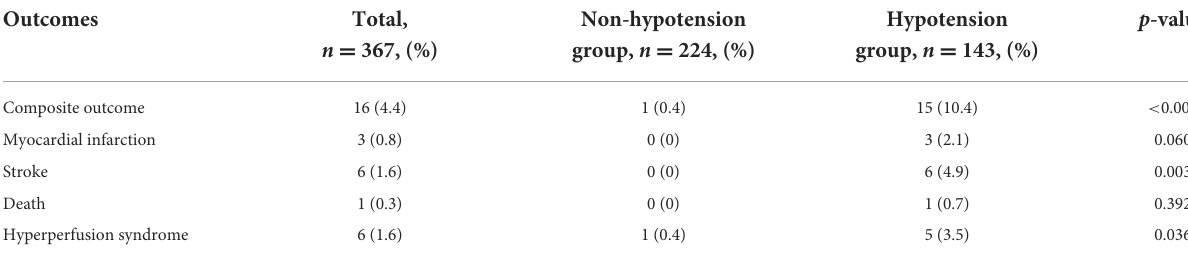
TABLE 2 Clinical outcome stratified for patients with hypotension or not.